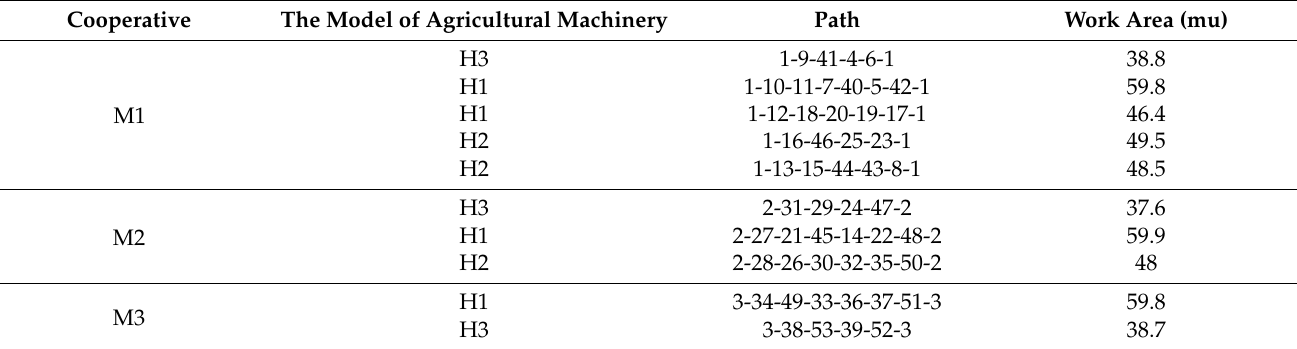
Table 8. The second stage agricultural machinery scheduling path sequence.